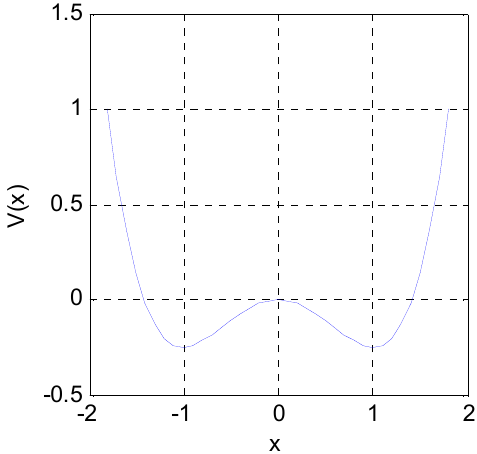
Figure 1. Potential function of a bistable system, showing that the motion can quickly converge to one of the two equilibrium points when the external force is missing.